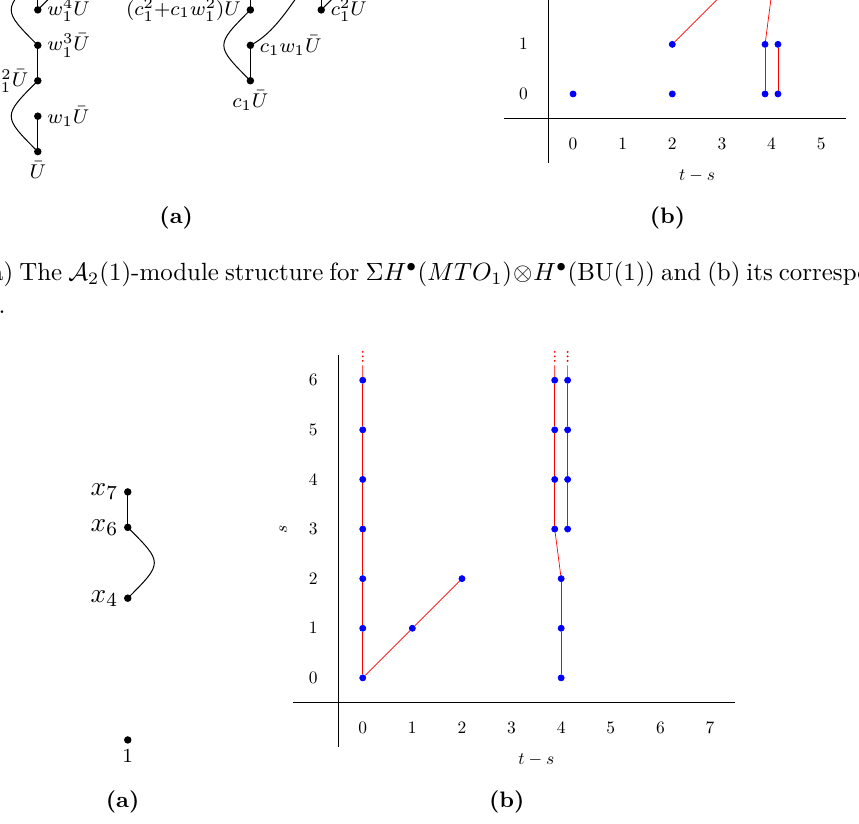
Figure 6. (a) The A 2 (1) -module structure for H • ( BG 2 ) and (b) its corresponding Adams